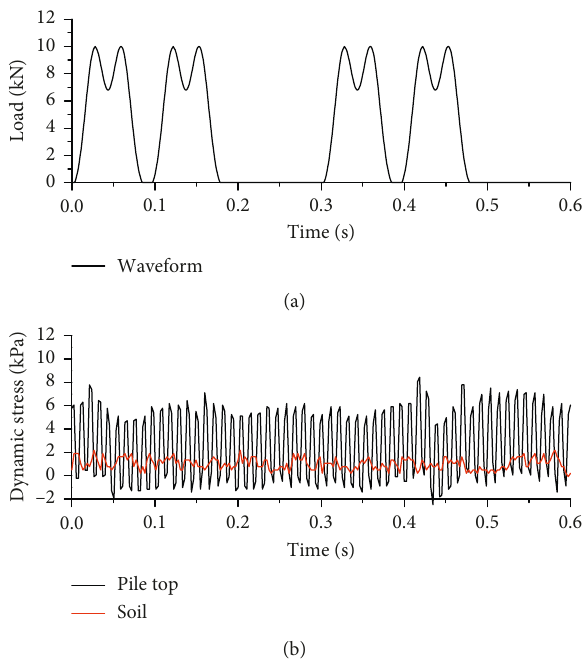
Figure 9: Dynamic stresses of pile and soil with respect to time.